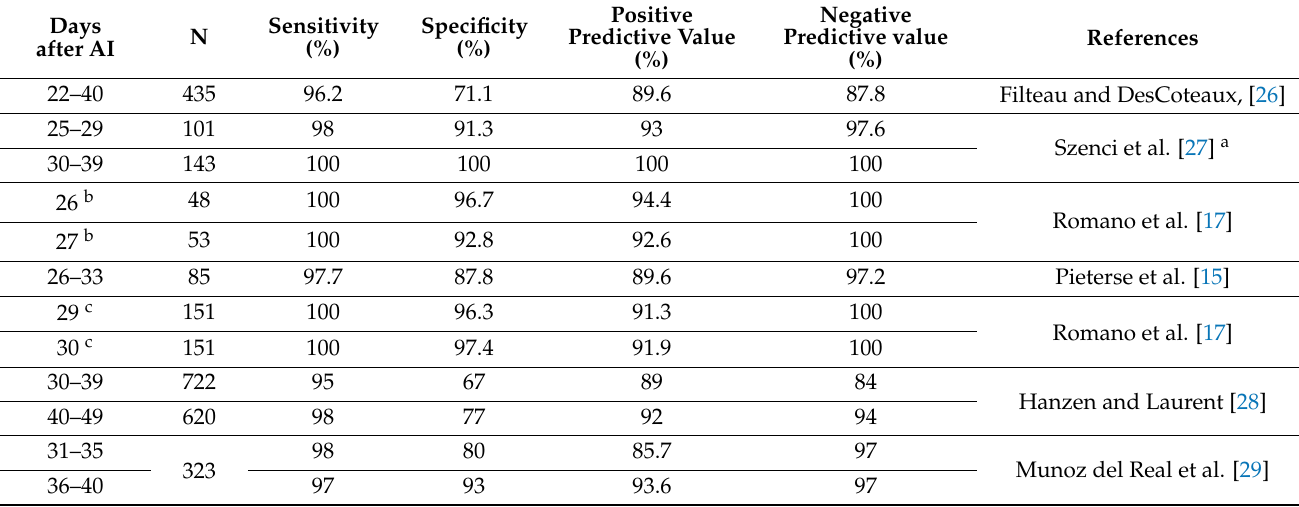
a Sector transducer, b Heifers, c Cows, NG: not given. Sensitivity = correct positive/correct positive + false negative × 100. Specificity = correct negative/correct negative + false positive × 100. Positive predictive value = correct positive/correct positive + false positive × 100. Negative predictive value = correct negative/correct negative + false negative ×